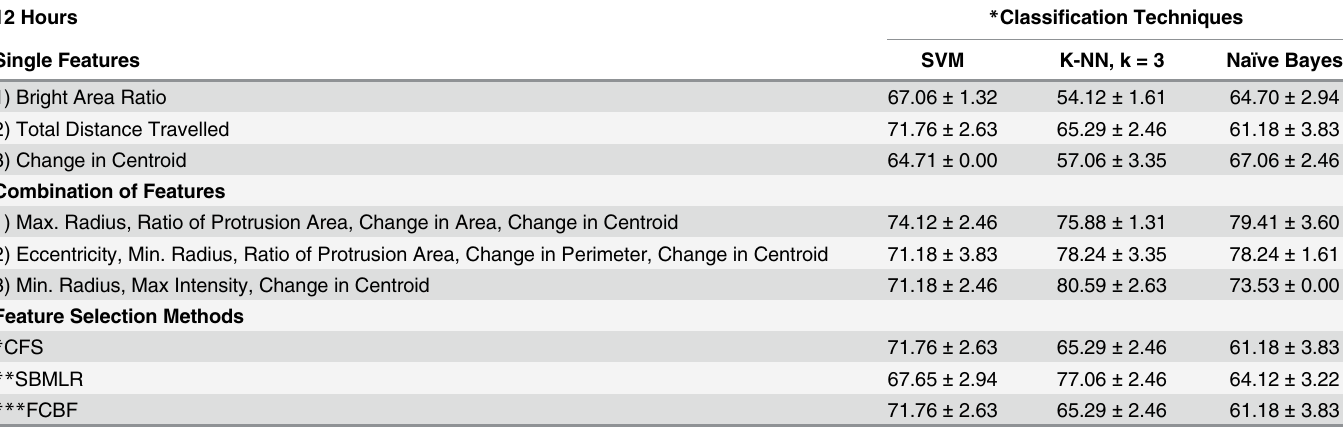
Table 4. Classification Results Using 12 Hours of